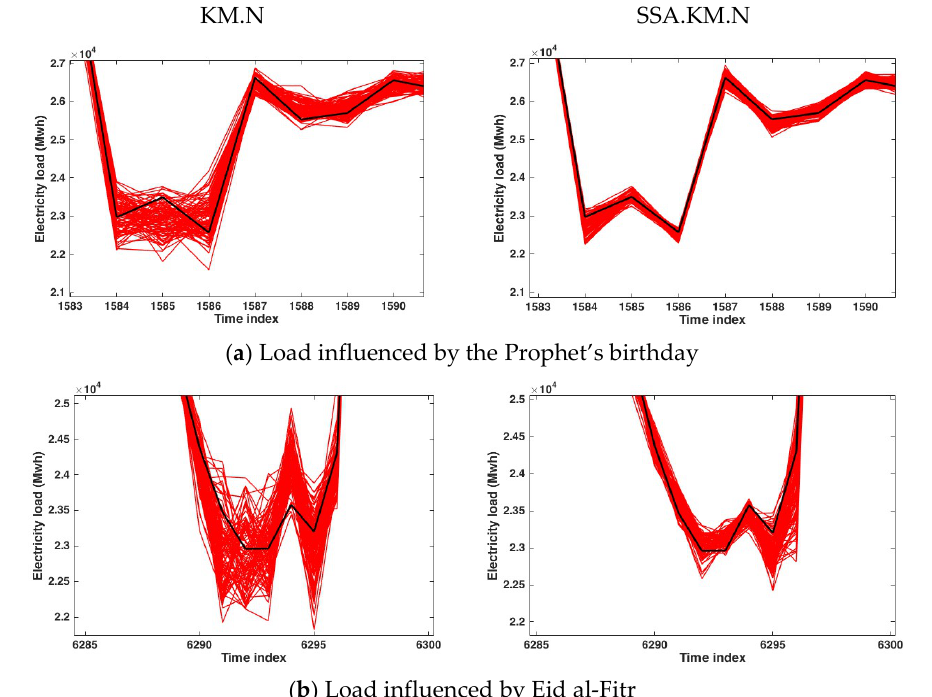
Figure 4. The original series (in black) and the bootstrap time series (in red) obtained by the KM.N method (left) and SSA.KM.N (right) ( a ) for time period influenced by the Prophet’s birthday; ( b ) for time period influenced by the Aid al-Fitr.